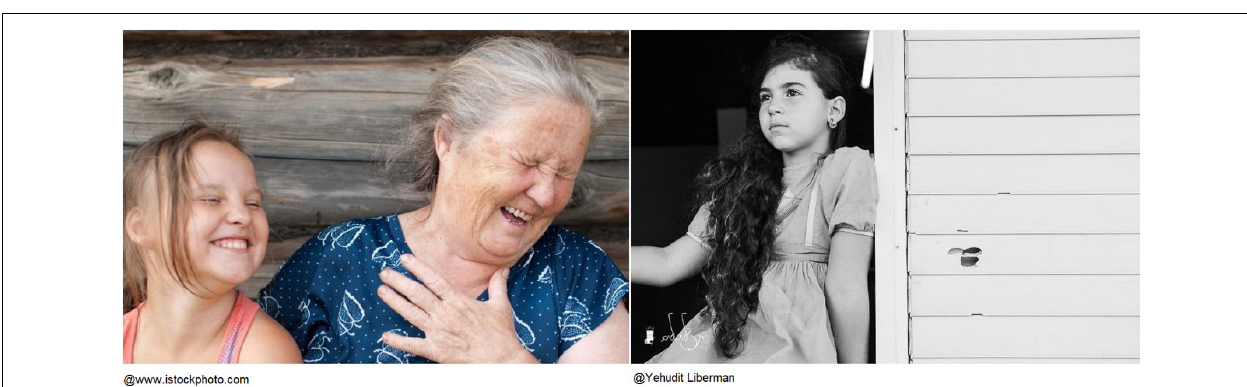
FIGURE 5 | Lea’s photographs and titles: “The first snow” and “Birds migrate but together.”